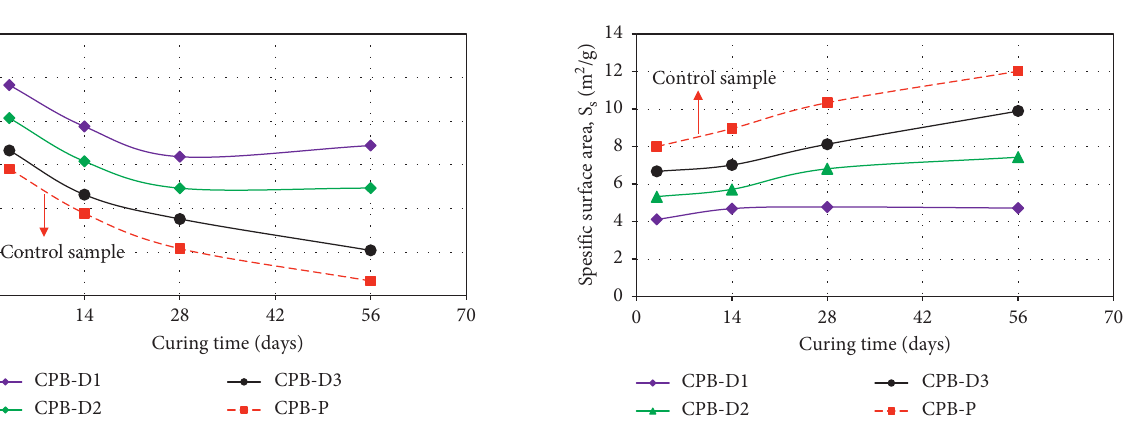
Figure 8: Change in S s values with time for diverse mine